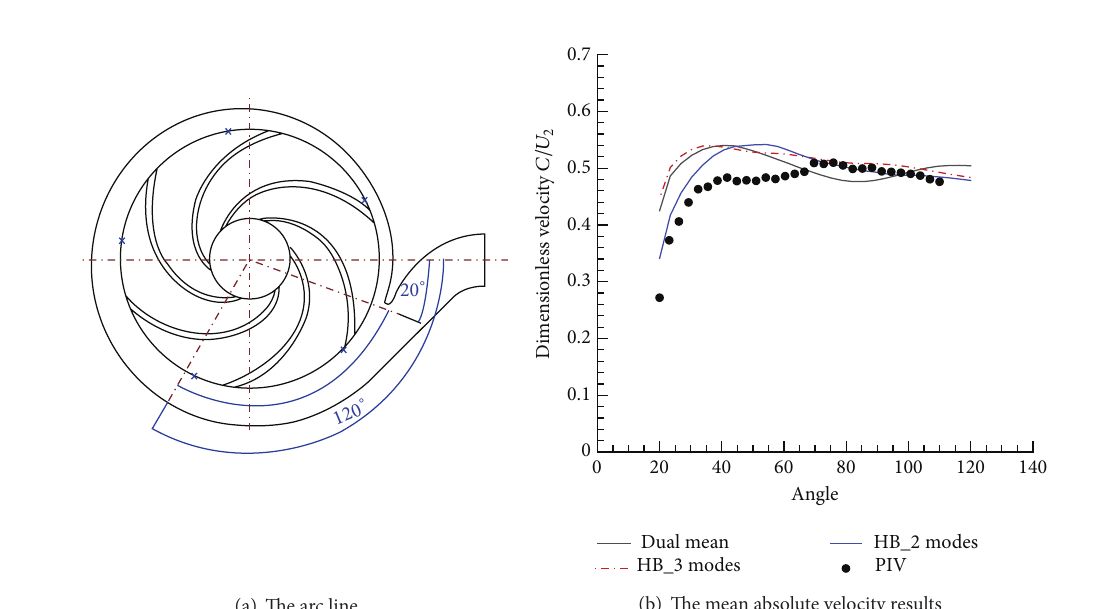
Figure 5: Absolute velocity results from different HM modes (for the 2nd level mesh) and